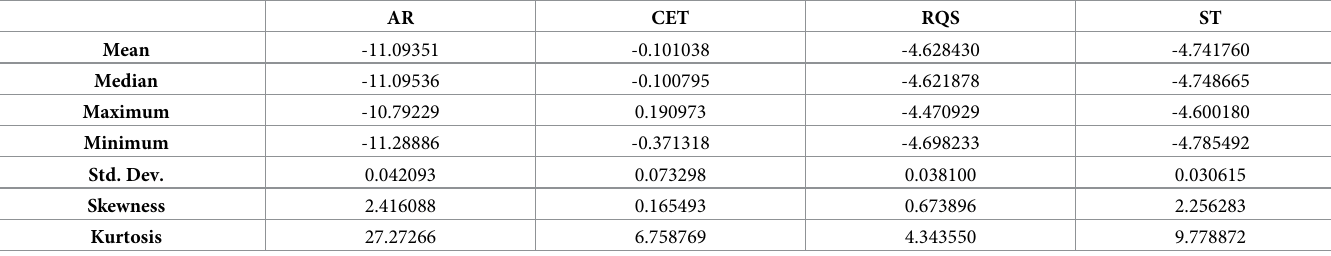
Table 1. Descriptive statistics of the liquidity measures for the full